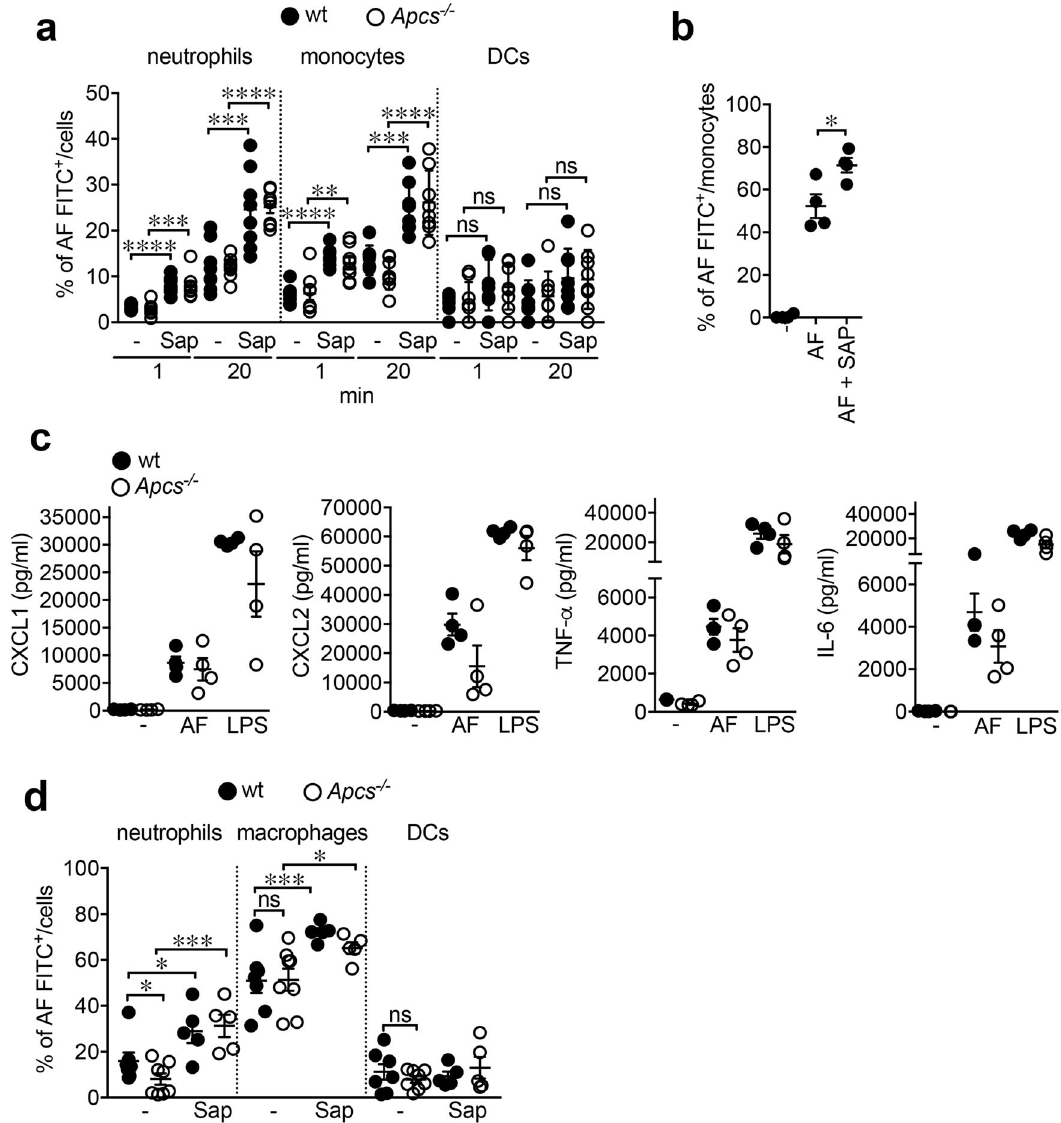
Fig. 5 Effects of SAP on myelomonocytic cell function. a FACS analysis of phagocytosis (1 and 20min) of FITC-labeled AF conidia opsonized with murine SAP by peripheral murine neutrophils (Ly6G + CD11b + ), monocytes (Ly6C + CD11b + ) and DCs (CD11c + ) (1×10 7 conidia/200 µ l of blood). N = 7 wt, n = 8 Apcs − / − . wt vs. wt + Sap, **** P <0.0001 (1min), *** P = 0.003 (20min) (neutrophils); **** P <0.0001 (1min), *** P = 0.002 (20min) (monocytes). Apcs − / − vs. Apcs − / − + Sap, *** P = 0.0004 (1min), **** P <0.0001 (20min) (neutrophils); ** P = 0.005 (1min), **** P <0.0001 (20min) (monocytes) (two-sided, unpaired t -test). b Effect of human SAP opsonisation on in vitro phagocytosis by isolated human monocytes ( n = 4 donors) (1×10 5 cells and 1×10 6 FITC-labeled AF conidia; 30min; 10% of autologous serum). * P = 0.03 (two-sided, unpaired t -test). c Levels of CXCL1, CXCL2, TNF- α , and IL-6 in supernatants of bone marrow-derived macrophages from wt and Apcs − / − mice stimulated (24h) with A . fumigatus conidia (ratio 1:5, cell:conidia) in the presence of correspondent mouse serum (10%). LPS, 10ng/ml. n = 4 mice per genotype. d FACS analysis of FITC-labeled AF conidia phagocytosis by neutrophils (CD45 + Ly6G + ), macrophages (CD45 + Ly6C + F4/80 + ) and DCs (CD45 + CD11c + ) collected from BALFs of wt ( − , n = 7; Sap, n = 5) and Apcs − / − ( − , n = 8; Sap, n = 5) mice after i.t. injection of 5×10 7 conidia (4h) opsonized with murine SAP. d Neutrophils, wt vs. Apcs − / − , *, P = 0.05; wt vs. wt + Sap, *, P = 0.03; ***, P = 0.0003. Macrophages, * P = 0.030; *** P = 0.004 (two-sided, unpaired t -test). a – d Each spot corresponds to a single mouse ( a , c , d ) or single healthy donor ( b ). a – d Mean±SEM of